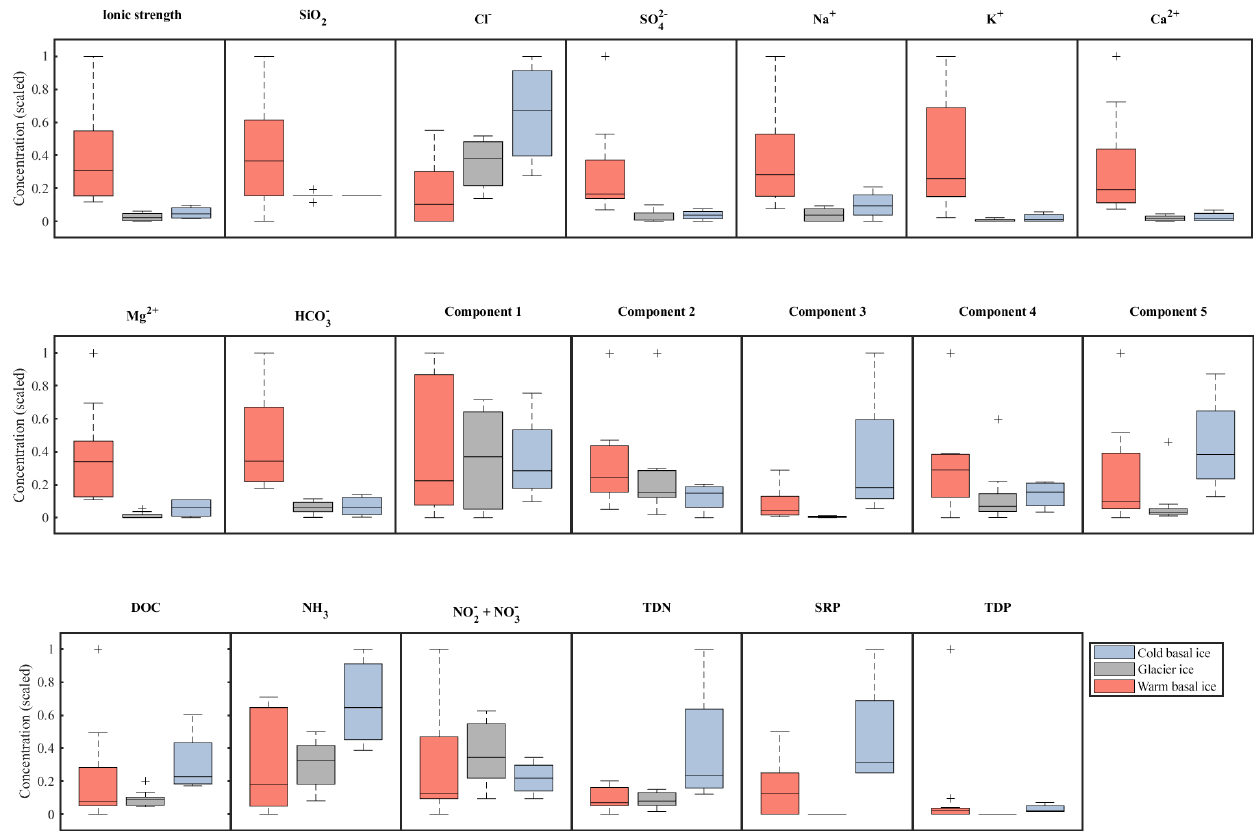
Figure 3. Relative abundance and range in concentrations of major ions (top row), organic nutrients (middle row), and inorganic nutrients (bottom row) in basal ice and glacier ice. Data were scaled to the interval 0–1. Boxplots indicate the median, 25th, and 75th percentiles; whiskers indicate the most extreme datapoints that are not considered outliers; and outliers are indicated with a “ + ”